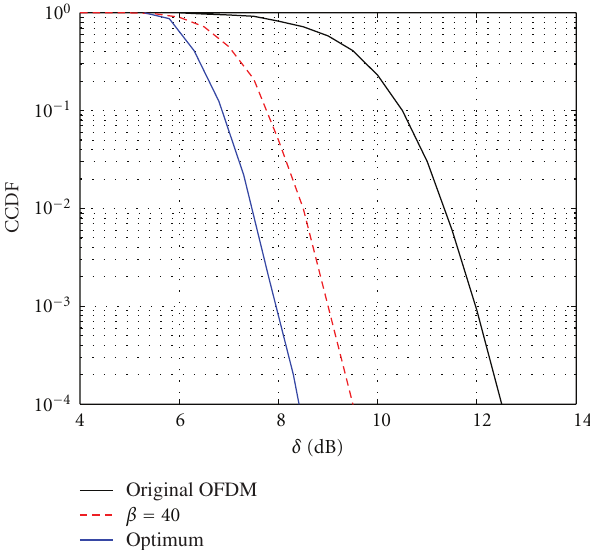
Figure 9: PAPR with the gradient-based algorithm in [16] using randomly chosen subcarriers for the PRTs, L/N = 6 . 3%, β = 40, and x SAT = 6dB.